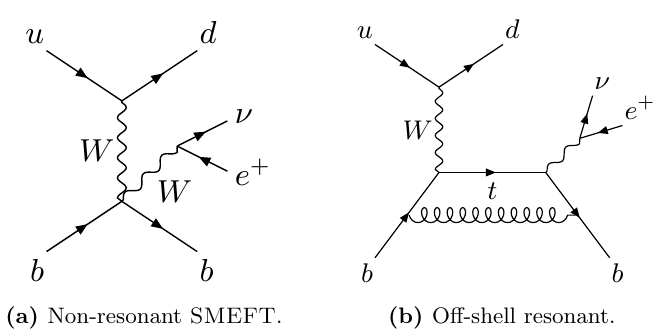
Figure 2. (a) Example non-resonant contribution in the SMEFT at LO . (b) One-loop resonant diagram with production-decay interference.